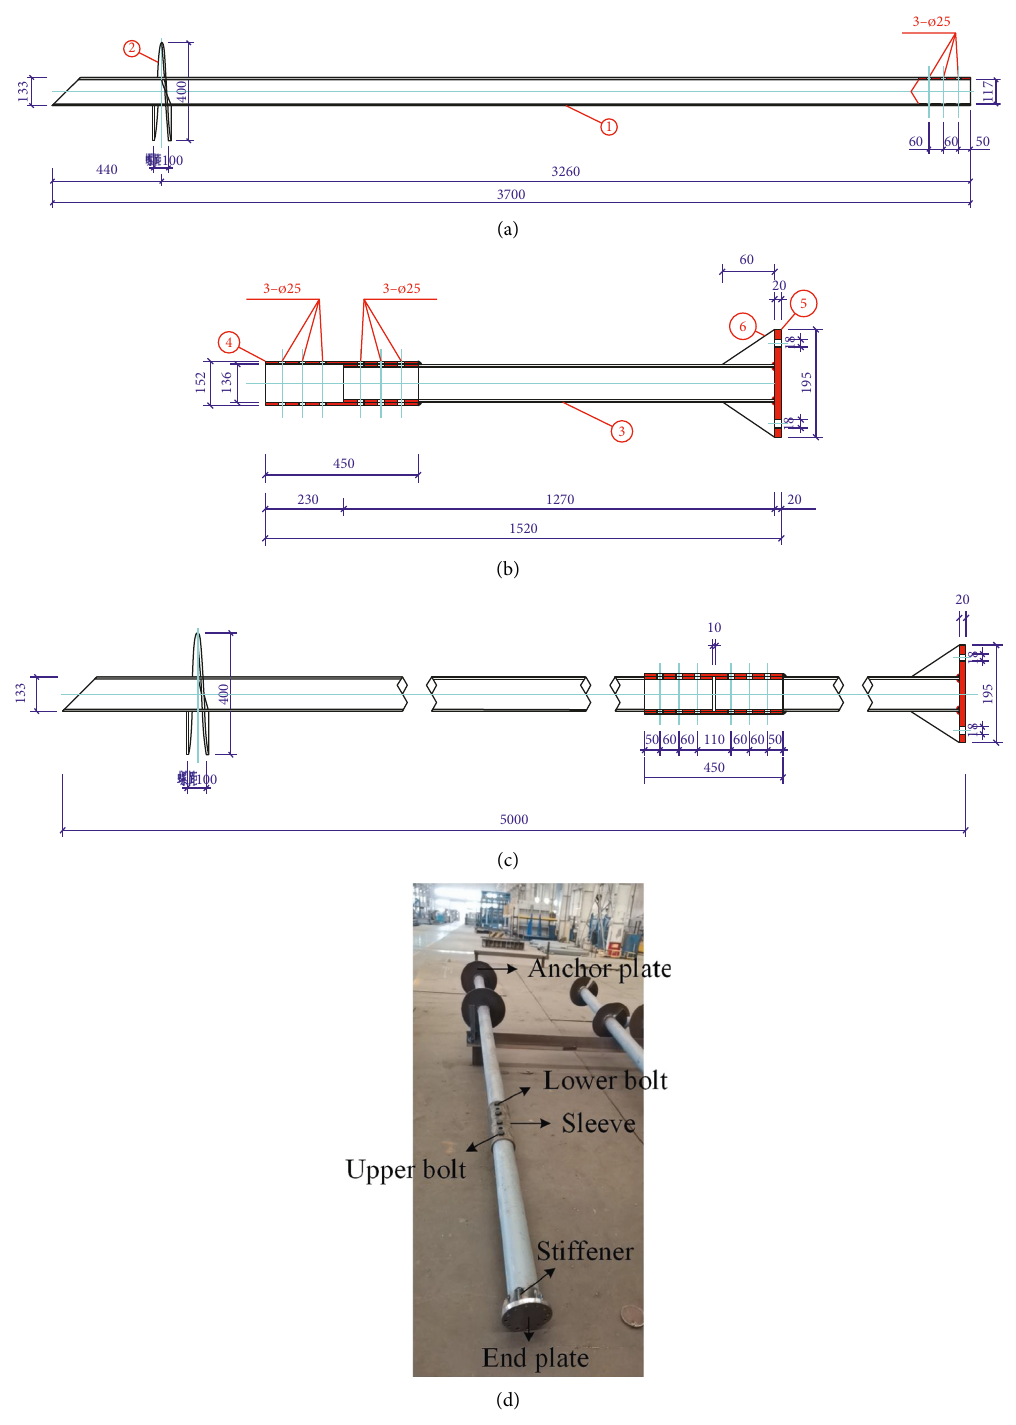
Figure 1: Spiral anchor specimen design. (a) Guide section: (1) lower bolt and (2) anchor plate. (b) Rod cap segment: (3) upper bolts, (4) sleeves, (5) end plates, and (6) stiffeners. (c) Integral assembly. (d)